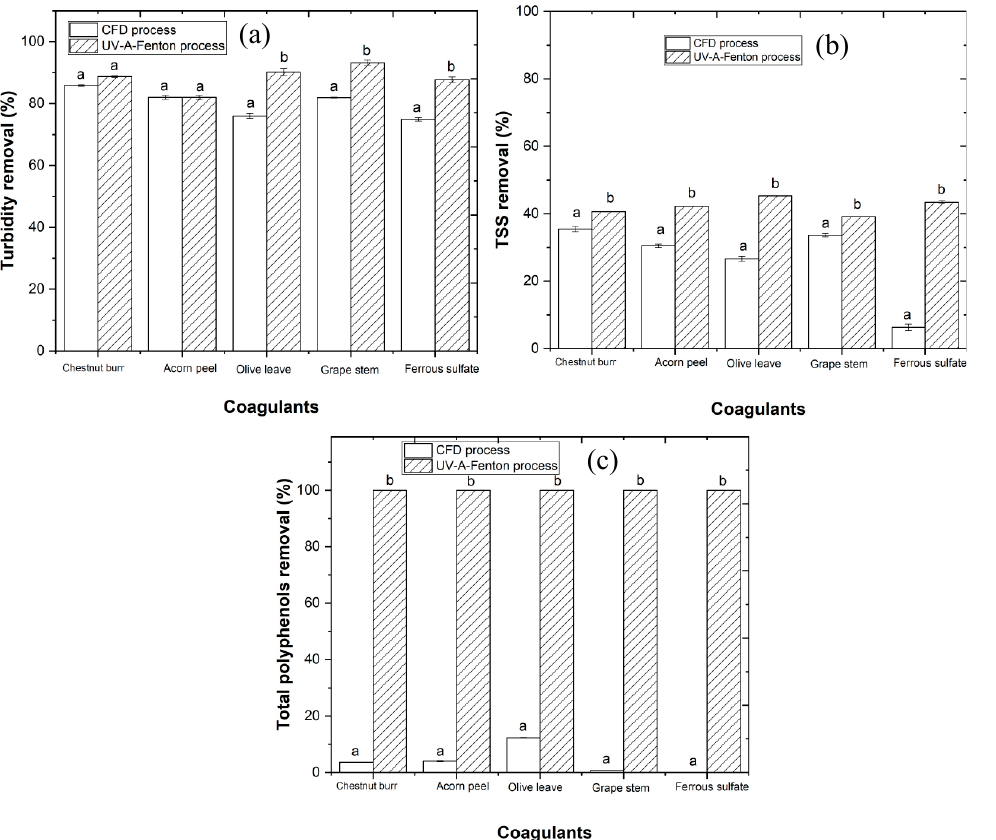
Figure 13. Progress of ( a ) turbidity, ( b ) TSS, and ( c ) total polyphenols percentage removal as a result of CFD process (with plant-based coagulants) in comparison with UV-A-Fenton under the following experimental conditions: [H 2 O 2 ] = 38.8 mM, [Fe 2+ ] = 1.0 mM, pH = 3.0, agitation = 350 rpm, T = 25 °C, t = 90 min. Different letters between the graphic bars mean values are statistically different ( p < 0.05).